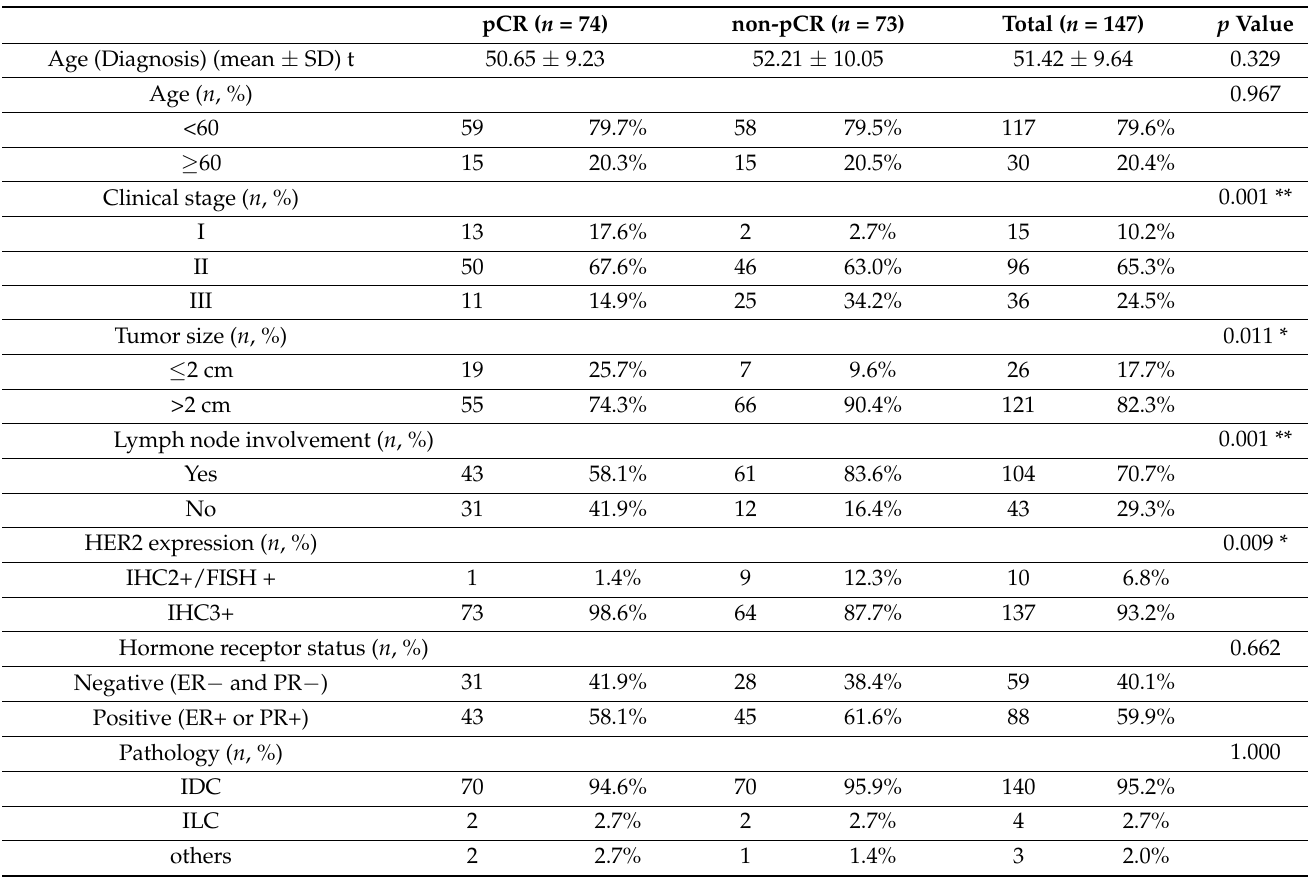
Figure 2. The survival curves of patients who received neoadjuvant chemotherapy with dual-blockade versus single-blockade therapy. ( A ) Disease-free survival. ( B ) Overall survival. C/T, chemotherapy; T, Trastuzumab; p , Pertuzumab. Table 2. pCR by Table 4. Recurrence sites between single-target therapy and dual-target therapy. Some patients had more than one recurrent site.